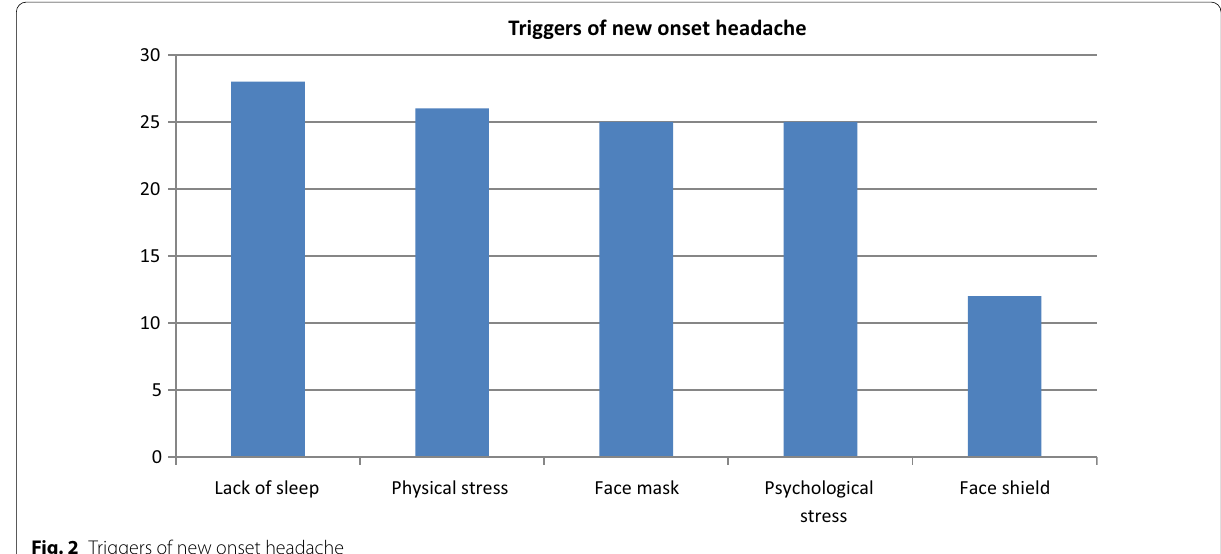
Fig. 2 Triggers of new onset